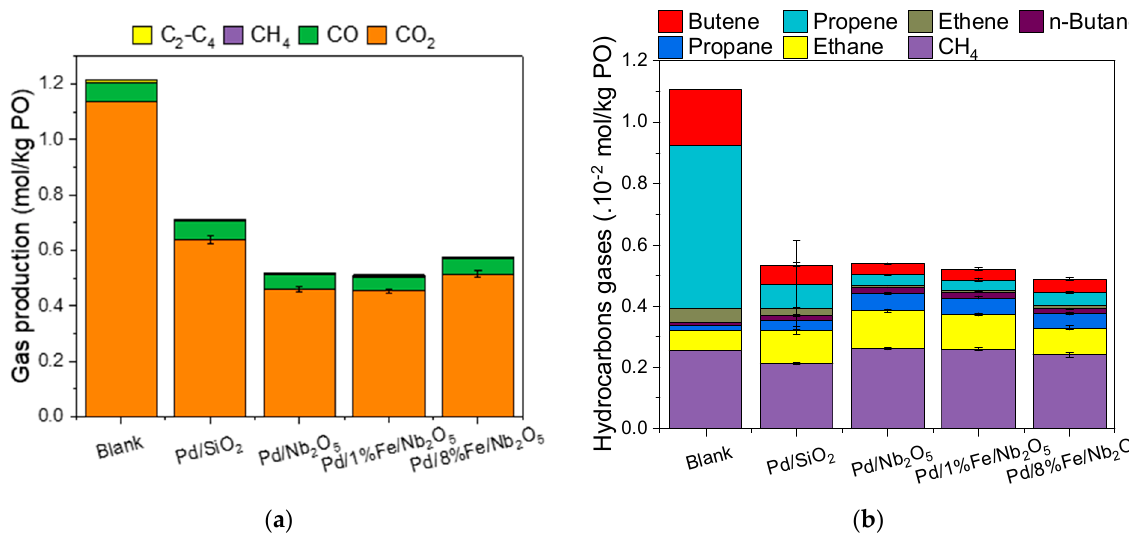
Figure 3. ( a ) Total gas production and ( b ) hydrocarbon production during the bio-crude hydrotreatment on different catalysts.